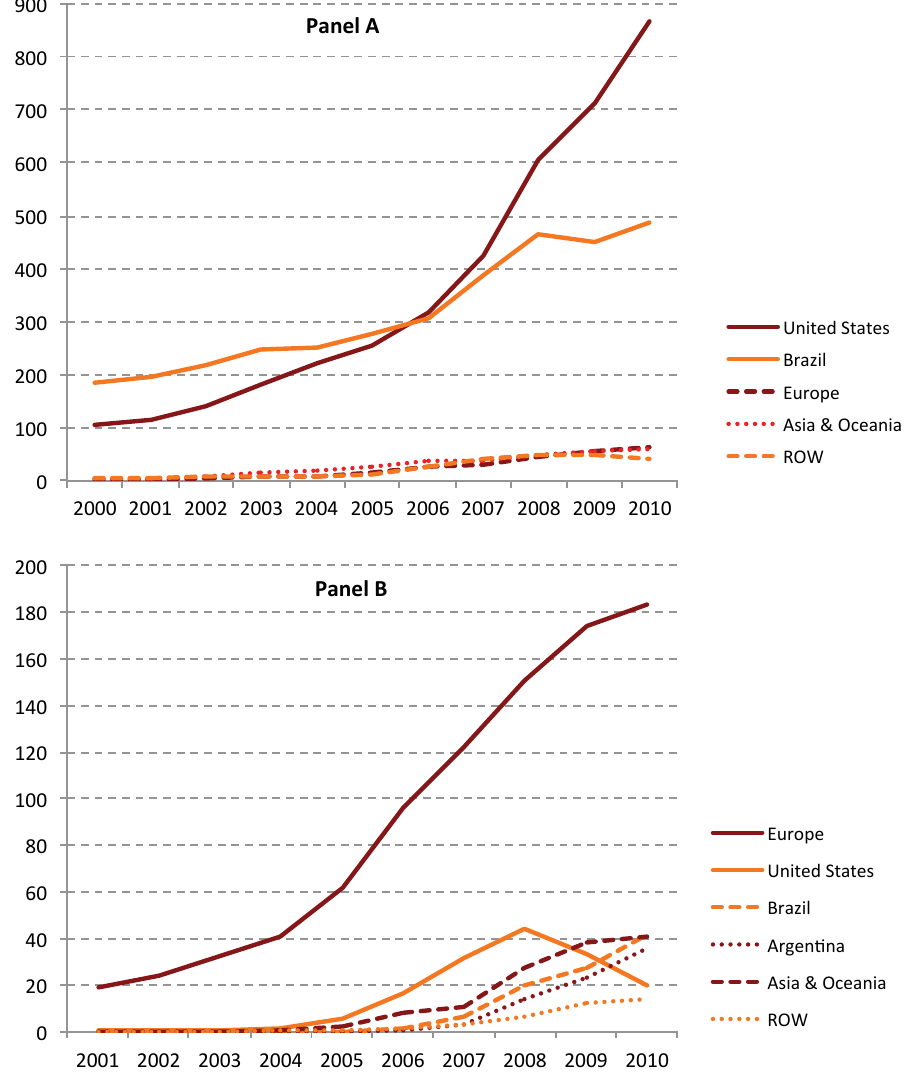
Figure 1. World production of biofuels (thousand barrels per day). Panel A: ethanol; Panel B: